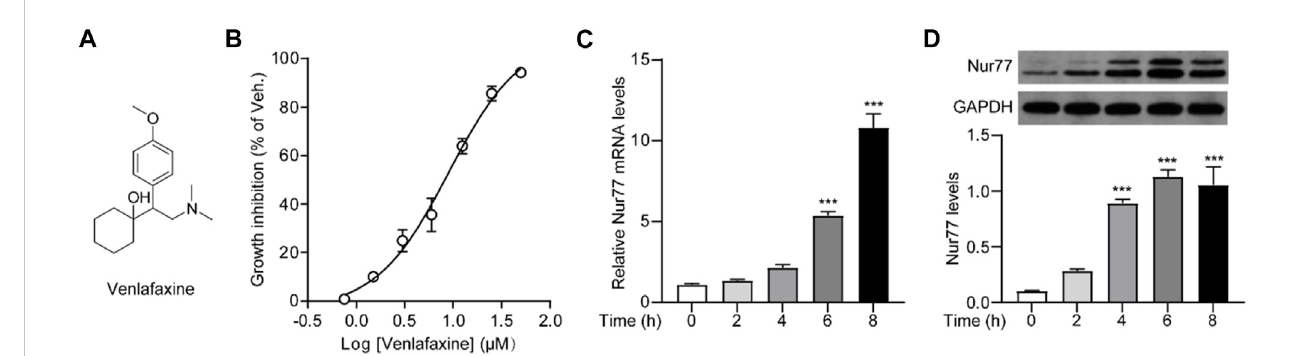
FIGURE 1 Cellular viability was correlated to Nur77 expression induced by venlafaxine. (A) Chemical structure of venlafaxine. (B) Dose-dependent inhibition of venlafaxineonthegrowthinhibitionofMV3cellsat72 h. (C) RelativemRNAexpressionsofNur77inMV3cellswerequanti fi edaftertreatmentwithvenlafaxine (10 μ M)for0 – 8 h. (D) TheproteinexpressionofNur77inMV3cells wasdetectedbyWestern blotafter treatment withvenlafaxine (10 μ M) for0 – 8 h.Intensity of the protein bands was quanti fi ed and normalized to loading control GAPDH. N = 3, ***, p < .001 vs. control (0